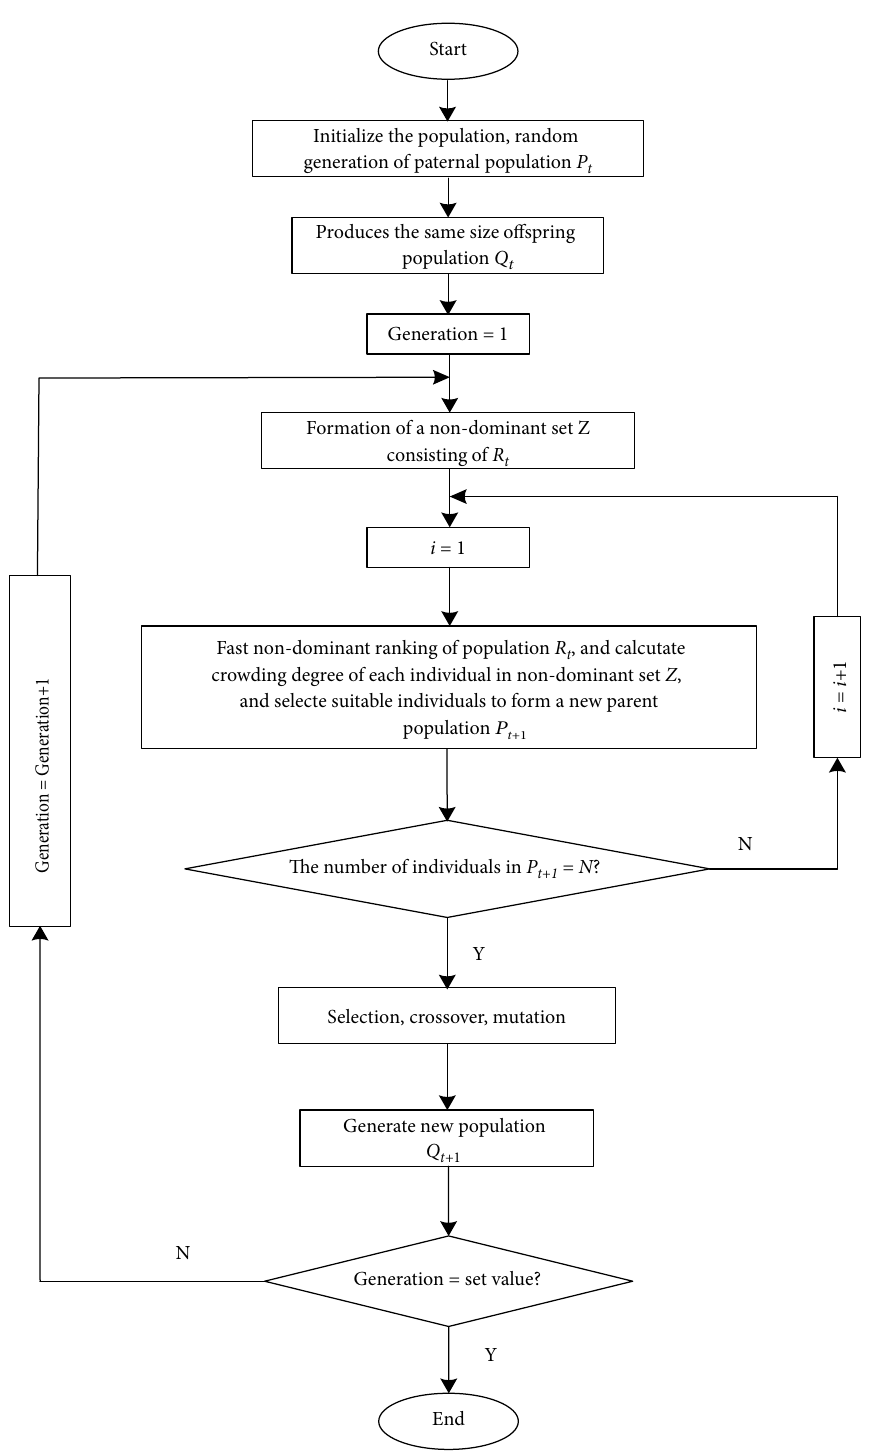
Figure 7: The framework of the NSGA-II